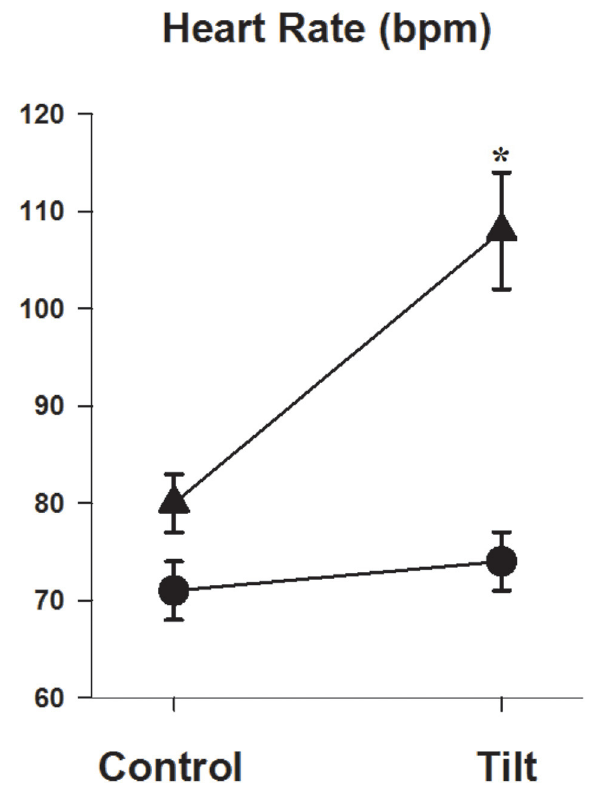
FIGURE 2 | Heart rate response during head up tilt. Graph showing heart rate in the semi recumbent position and at 60 ◦ head up tilt in patients with POTS ( (cid:2) ) and in healthy subjects ( • ). ∗ P < 0 . 05, n = 26 control and 11 POTS.